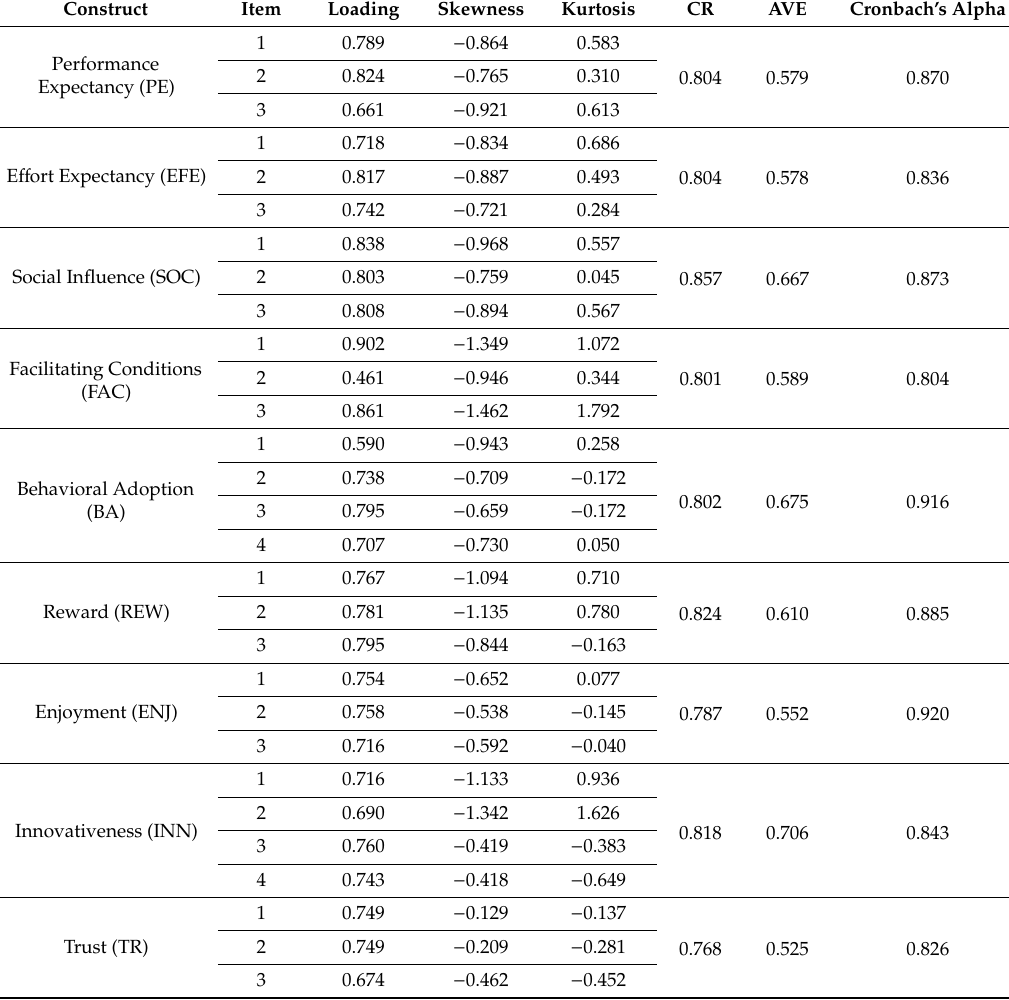
Table 5. Standardized factor loadings and individual item